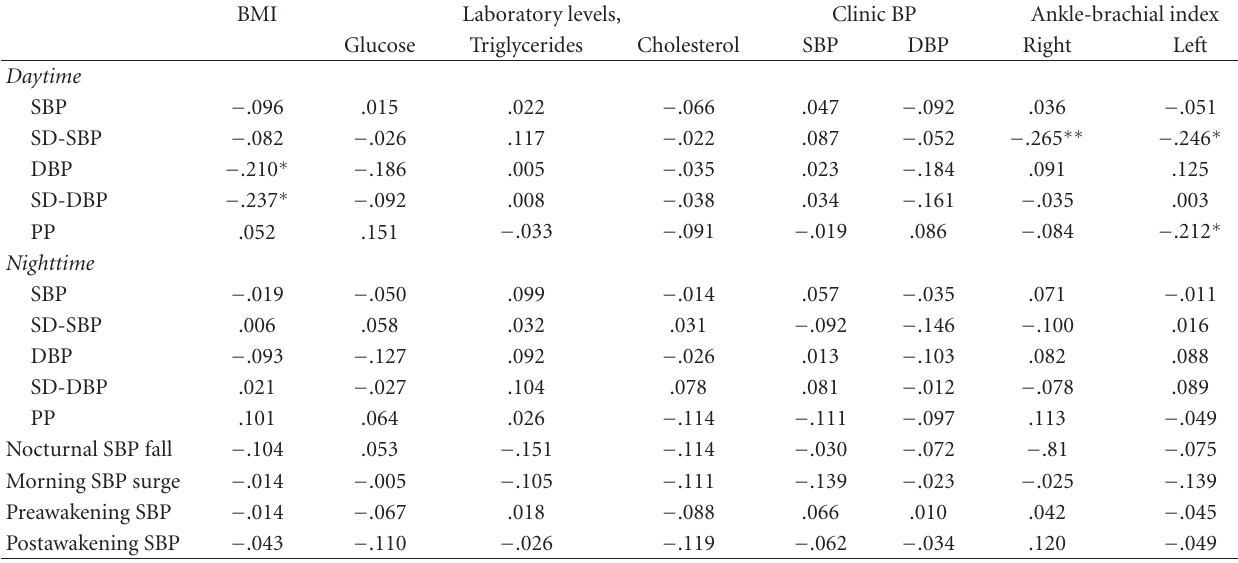
Table 3: Correlation coe ffi cients calculated for ambulatory blood pressure at age 82 and vascular risk factors (BMI, laboratory levels and clinic blood pressure/BP) as well as for markers of vascular disease at age 68 (ABI: ankle-brachial index).